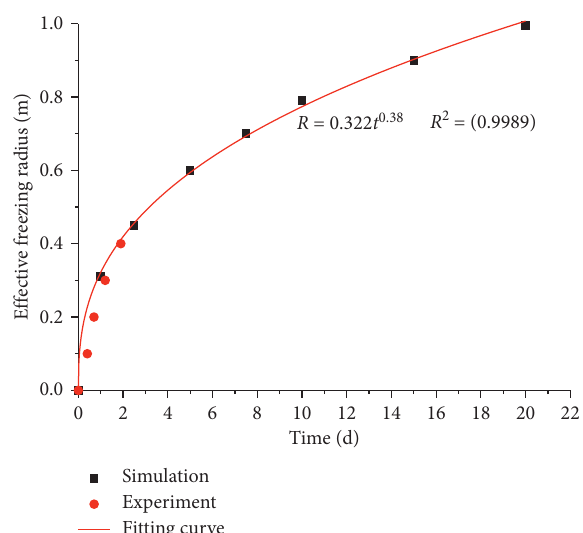
Figure 10: Variation of effective freezing radius with freezing